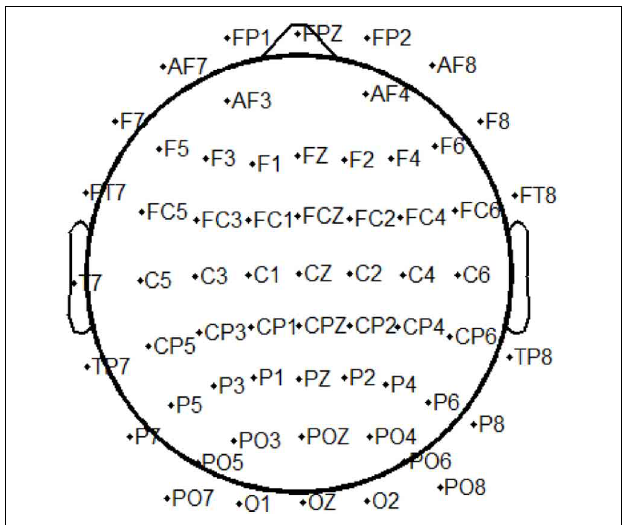
FIGURE A2 | Electrode positions and labels of the data set in the current study.